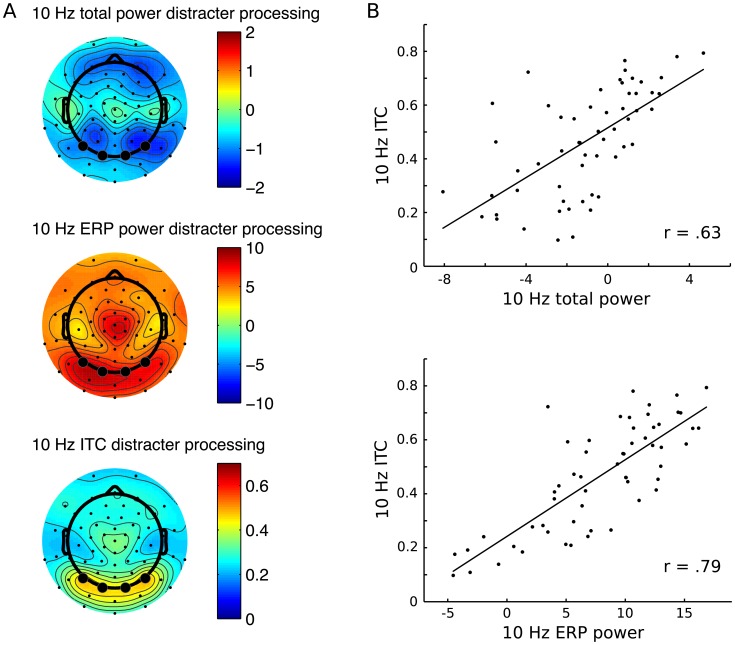
Power and ITC at 10 Hz as measures of entrainment.(A) Top: Total power at 10 Hz during the RSVP stream relative to the pre-RSVP baseline. The plot depicts the mean total power from 900 to 1900 ms post RSVP stream onset. Middle: Mean ERP power at 10 Hz from 900 to 1900 ms post RSVP stream onset relative to pre-RSVP baseline. Bottom: ITC at 10 Hz, mean value from 900 to 1900 ms post RSVP stream onset. (B) Scatter plots and regression lines of 10 Hz ITC and 10 Hz total power (top) and 10 Hz ITC and 10 Hz ERP power (bottom).